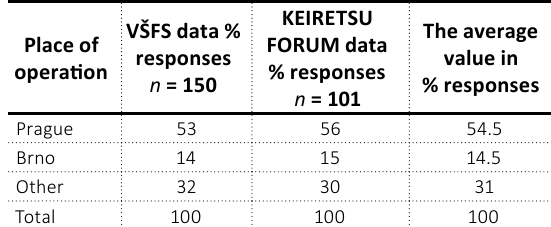
Table 2. Structure of analyzed startups according to a place of operation – a factor of location Table 3. Structure of analyzed startups by legal Source: Own processing. form of business – a factor of the suitability of